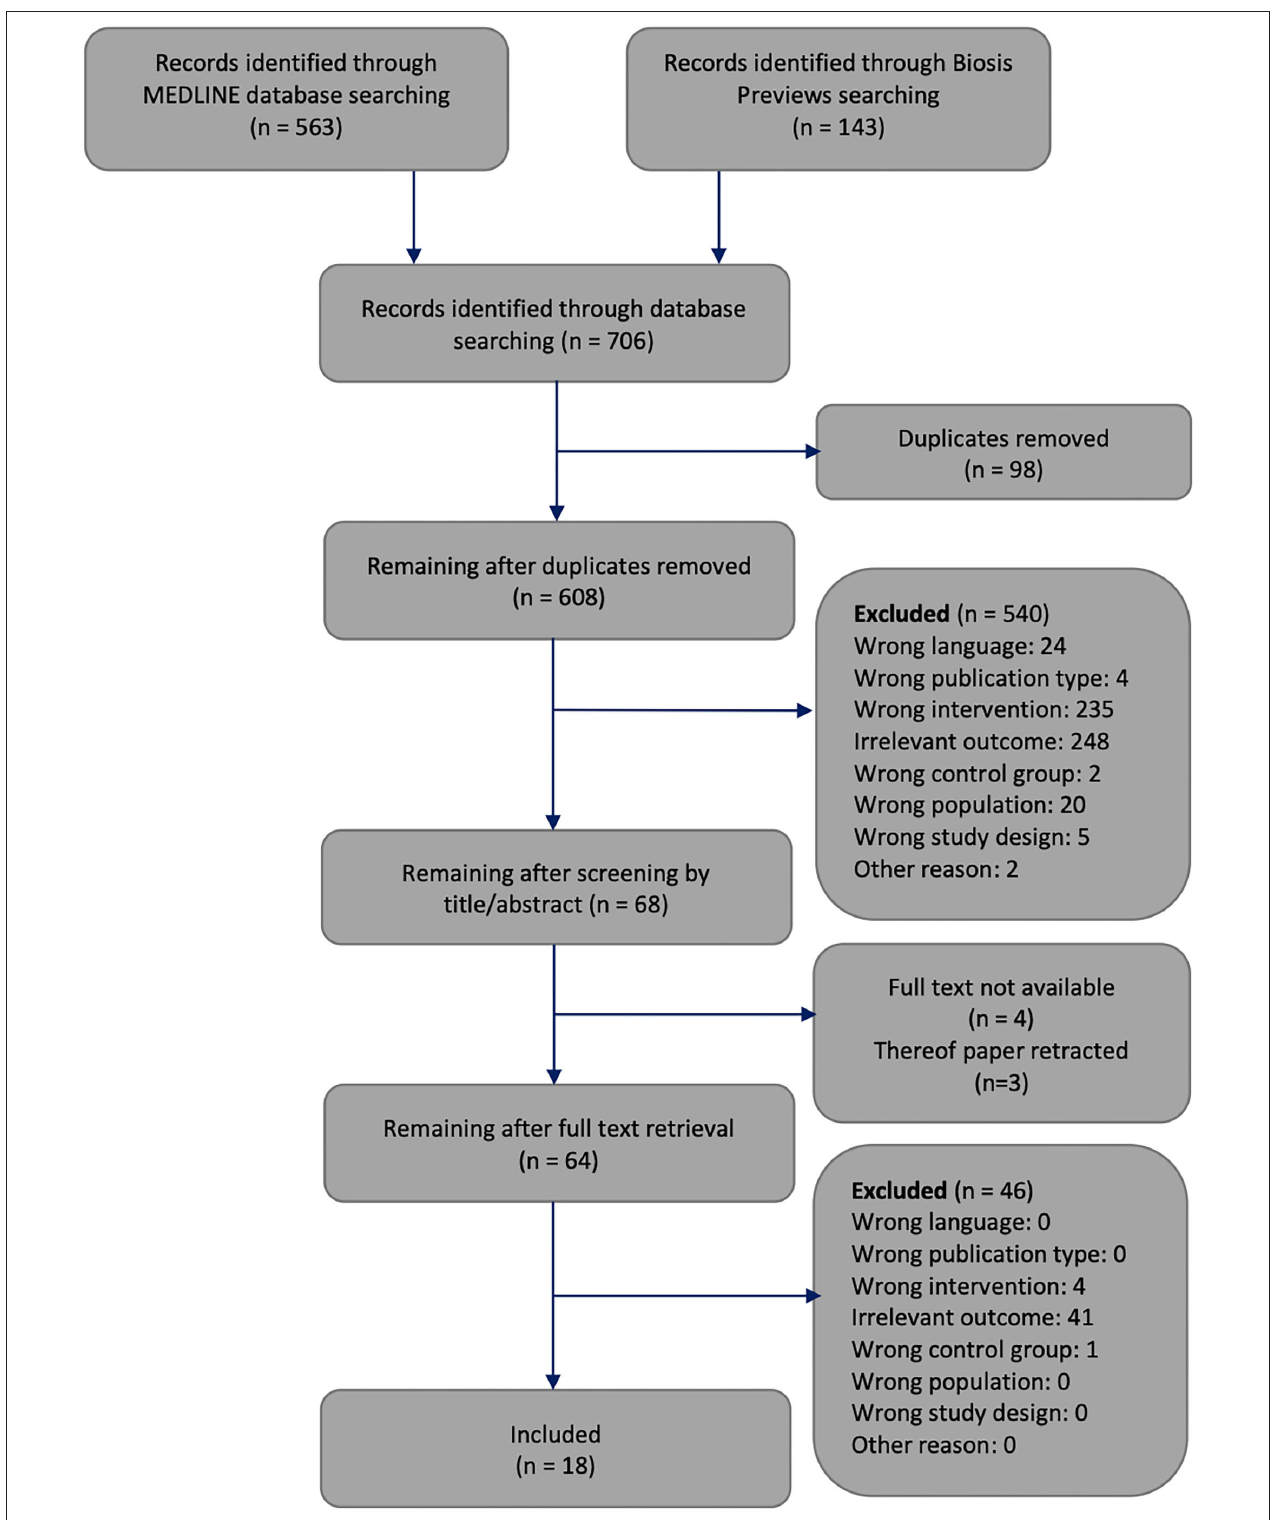
FIGURE 3 | Flowchart through different phases of the systematic review. The framework of this flowchart was taken from Moher’s publication (Moher et al., 2009).